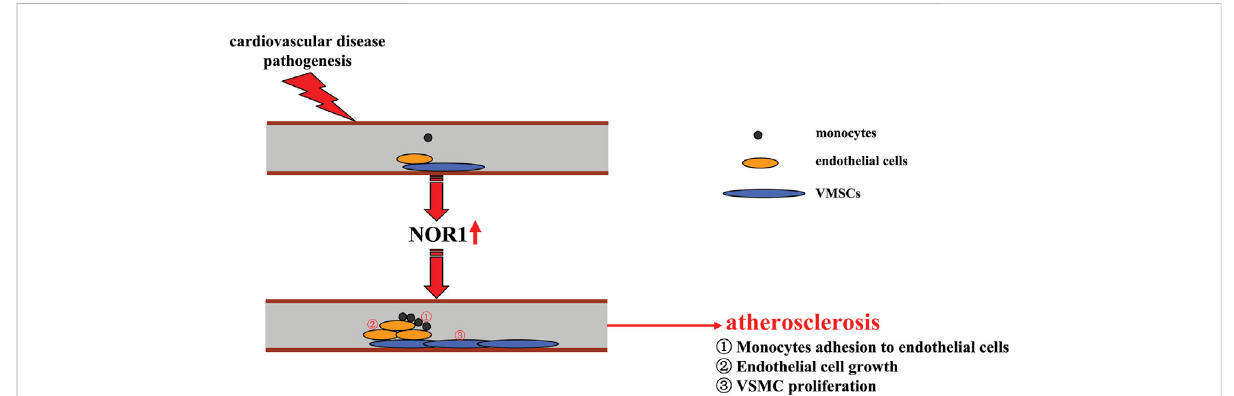
FIGURE 4 A schematic summary of how NOR1 might be involved in the development of cardiovascular diseases such as atherosclerosis. Pathologically elevated NOR1 could promote the development of atherosclerosis by inducing adhesion of monocytes to endothelial cells, increasing endothelial cell growth, and promoting proliferation of